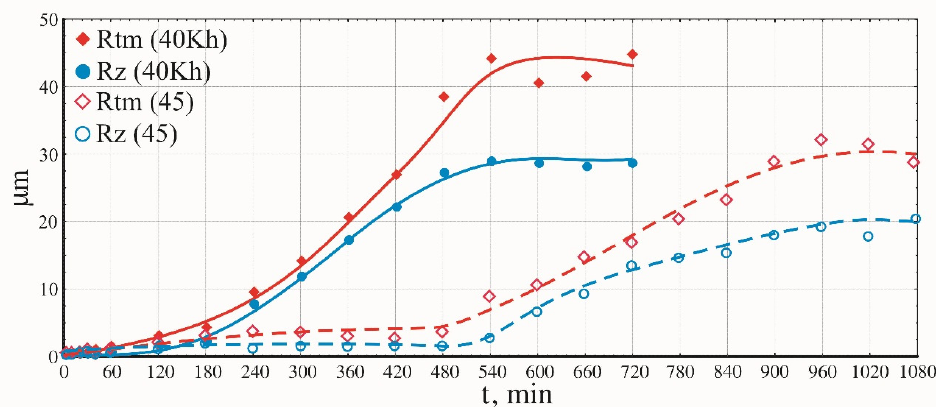
Figure 7. Dynamics of changes in the roughness parameters Rtm and Rz.